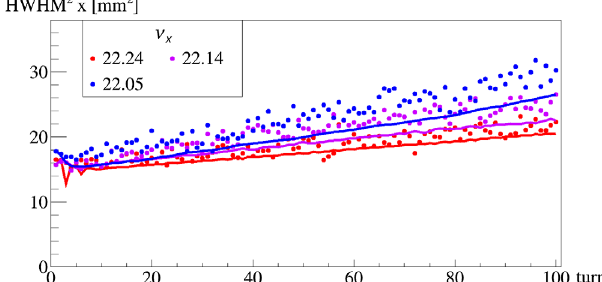
FIG. 8. Horizontal beam sizes in the NX22 experiment. The circles represent the results of the measurements. The color difference represents the difference in the horizontal tunes, which are shown in the upper left part of the figure. The vertical tunes were fixed to ν y ¼ 22 . 43 . The lines correspond to the simulation results for each